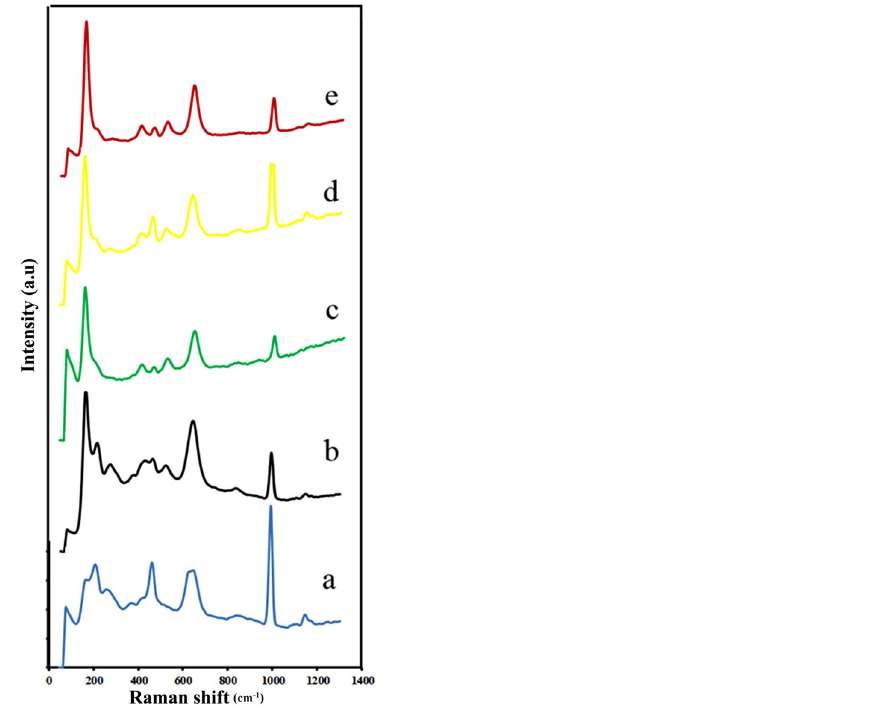
Figure 3. Raman spectra of ( a ) BaSO 4 –BaTiO 3 , ( b ) Cu–BaSO 4 –BaTiO 3 , ( c ) Fe–BaSO 4 –BaTiO 3 , ( d ) S– BaSO 4 –